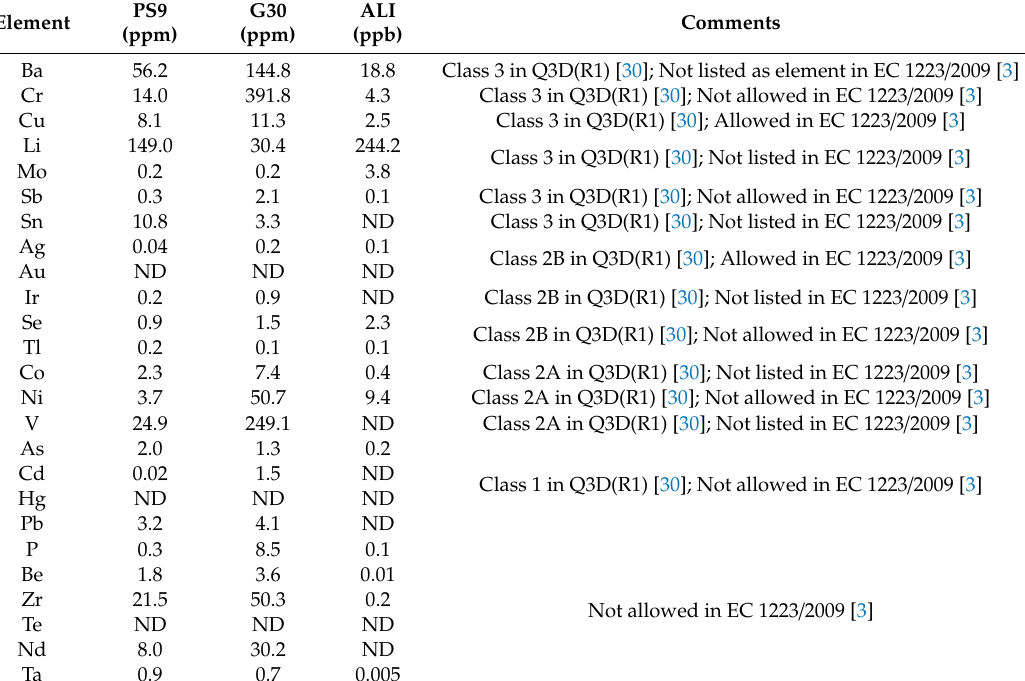
Table 2. Elemental composition of pristine ingredients (PS9 and G30 nanoclays and ALI spring water) determined by ICP-MS. The elements are classified depending on regulations [3,30]. “ND” stands for “Not